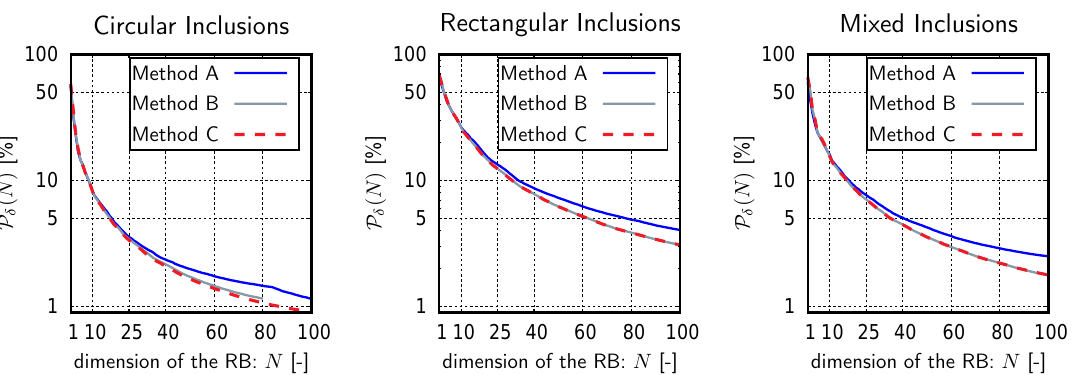
Figure 6. Relative projection error for three different microstructure classes as a function of the number of eigenmodes. The relative projection error is determined for a validation set of 1,500 newly generated microstructures for each